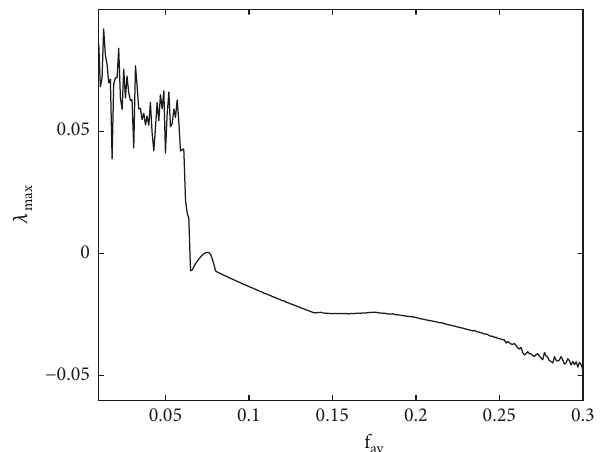
Figure 16: The maximum Lyapunov exponent spectrum.